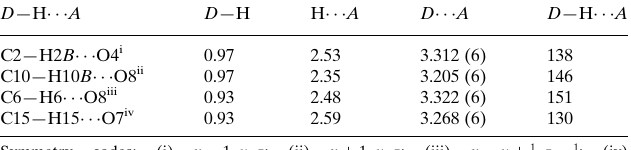
Hydrogen-bond geometry (A˚ , (cid:2)